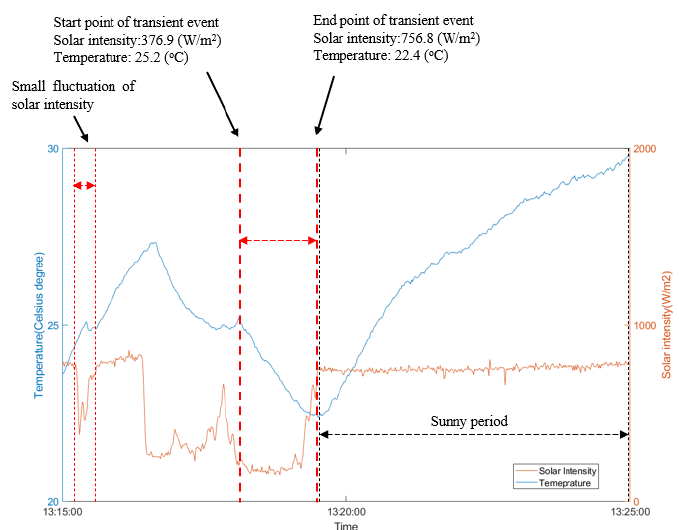
Figure 6. Temperature profile from a pixel on no-water region in the thermal image sequences and solar intensity history.